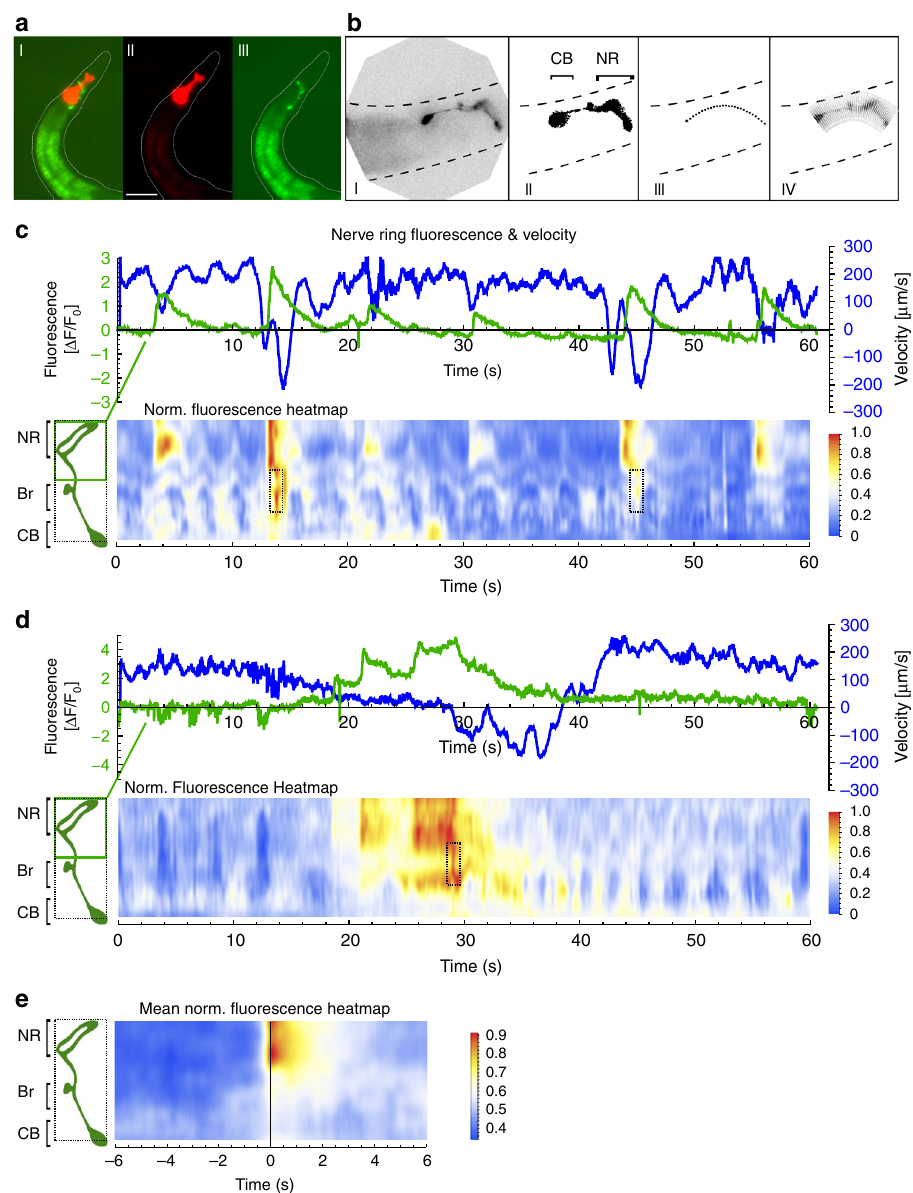
Fig. 5 Ca 2 + activity measured along the RIS axon in freely moving animals correlates with slowing and reversals: a Strain used for tracking and Ca 2 + imaging RIS in moving animals, expressing a red fl uorescent marker in the pharyngeal terminal bulb (for tracking) and GCaMP6s in RIS. Micrographs of red (II) and green (III) fl uorescence and merged color channels (I). Scale bar: 50 µ m. b Image analysis after binarization and repositioning the soma involved reorienting the raw image (I), masking unspeci fi c gut fl uorescence (II), fi tting a parabola (III), and measuring fl uorescence intensity in perpendicular rectangular ROIs (IV). Dorsal is up, anterior to the left; CB cell body, NR nerve ring. c , d Upper panels: Representative traces of animal velocity (blue) and fl uorescence intensity in the RIS nerve ring portion (green). Lower panels: Corresponding heat maps displaying the normalized fl uorescence dynamics along the axon over time. RIS pictograms on the left indicate morphology including nerve ring (NR), branch (Br), and cell body (CB), the distance along the axon as well as the region of the nerve ring (green box) used for calculating the Δ F / F 0 traces in the upper panels, while dashed region shows extent of ROIs analyzed in lower panels (also in e ). Distinct Ca 2 + rise events in the branch region are boxed. e Mean normalized fl uorescence heat map of n = 45 acquired Ca 2 + events along the entire length of RIS, partially excluding the soma, by aligning time windows 6 s prior and post Ca 2 + peaks ( N = 11